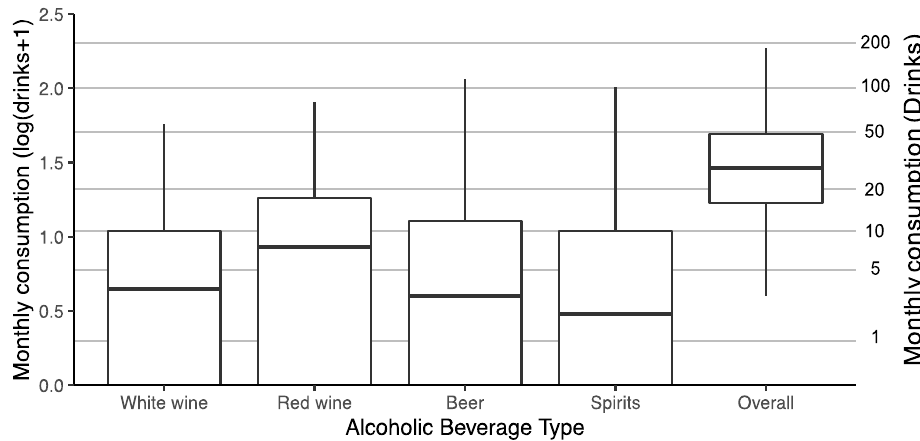
Figure A1. Boxplots showing the monthly consumption of alcoholic beverages overall and by type (white wine, red wine, beer, and spirits; n = 884).